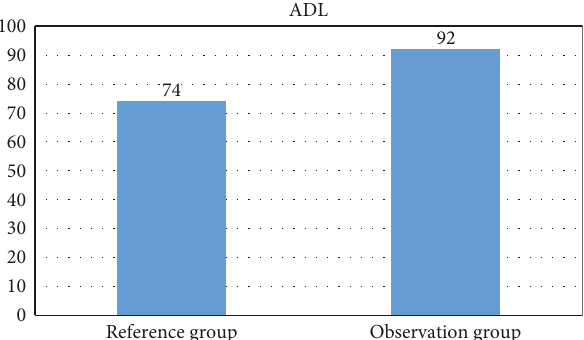
Figure 3: Visualization of the ADL score